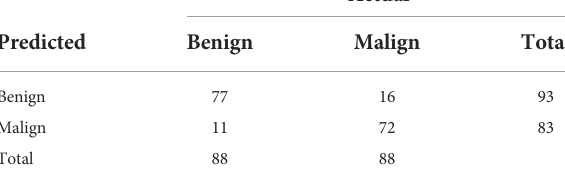
TABLE 2 Confusion matrix of the proposed CAD on the balanced data set.